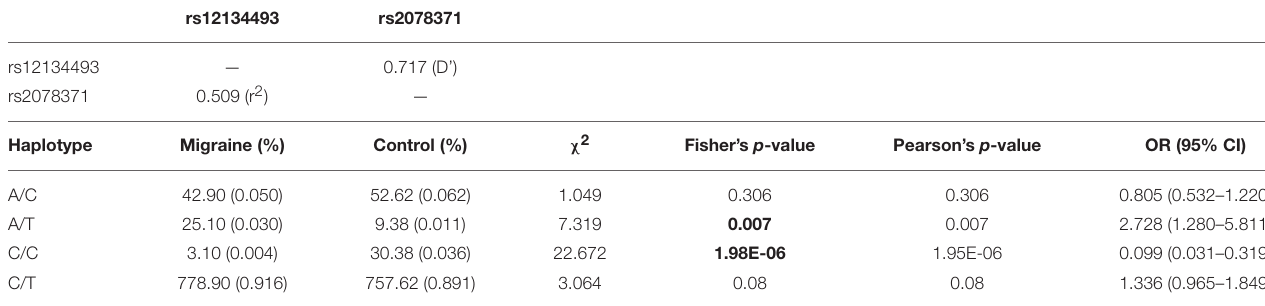
TABLE 5 | Linkage disequilibrium and distribution of haplotypes of the two SNPs in TSPAN2 between the cases and controls.